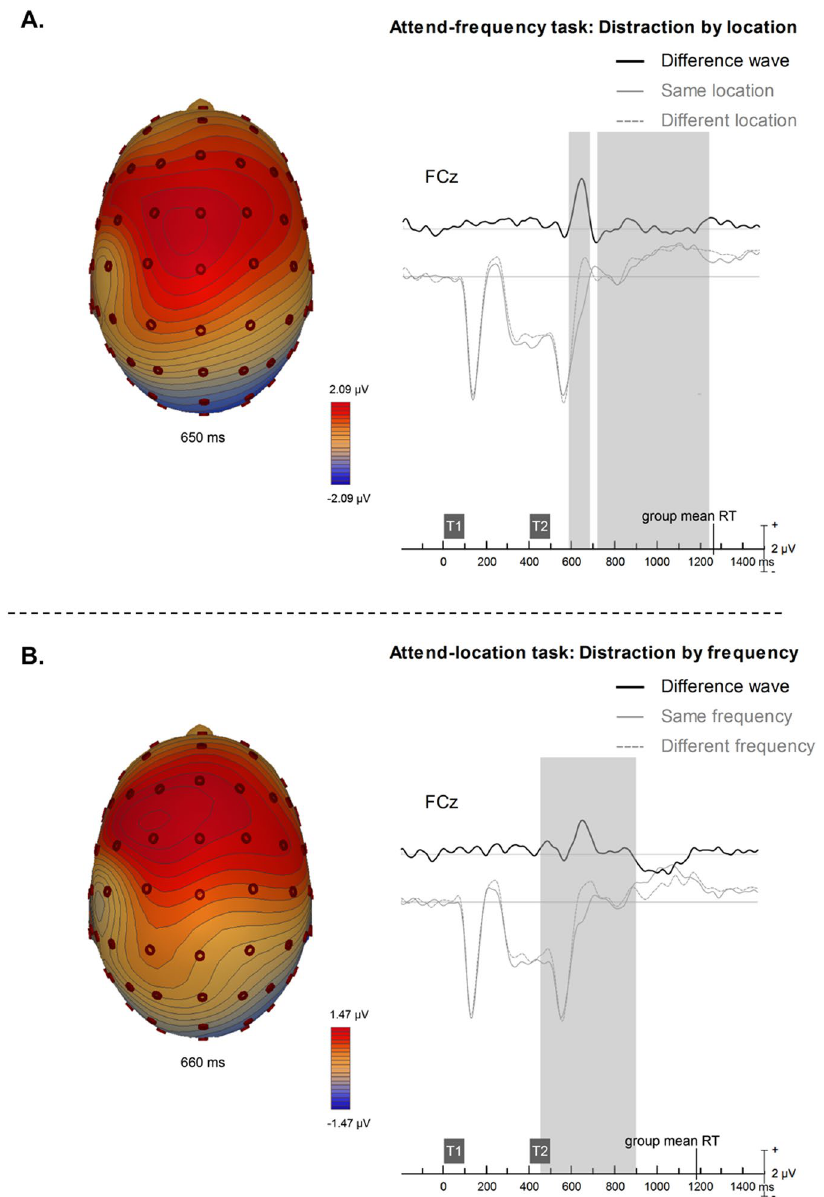
Figure 5. Distraction TAiL effect group mean event-related brain potentials recorded over the central frontal (FCz) scalp region for the ( A ) attend-frequency task and ( B ) attend-location task. T1 = first tone; T2 = second tone. Contour maps illustrate the brain activity at the peak of the difference waves. Shaded areas indicate the time period where the spatio-temporal cluster was significant, p < 0.05. For the attend-frequency task, the spatio-temporal cluster included the following electrodes: AF3, AFz, F5, F3, F1, Fz, F2, F4, F6, FC5, FC3, FC1, FCz, FC2, FC4, FC6, T7, C1, Cz, C2, C4, TP7, CP3, CP1, CPz, CP6, P9, P7, P4, P6, P8, P10, PO7, POz, PO4, PO9, O1, Oz, O2, and Iz. For the attend-location, the spatio-temporal cluster included the electrodes F1, Fz, F2, F4, FC5, FC3, FC1, FCz, FC2, FC4, FC6, C1, Cz, C2, C4, C6, CP1, CP2. Group mean RT across trials was 859 ms for the attend-frequency task and 793 ms for the attend-location task, time-locked to the onset of the second